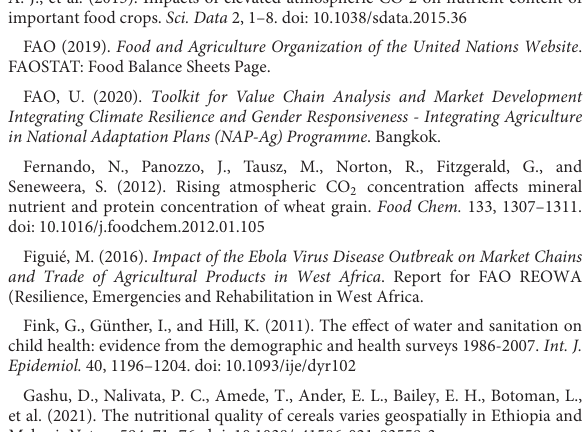
Figuié, M. (2016). Impact of the Ebola Virus Disease Outbreak on Market Chains and Trade of Agricultural Products in West Africa . Report for FAO REOWA (Resilience, Emergencies and Rehabilitation in West